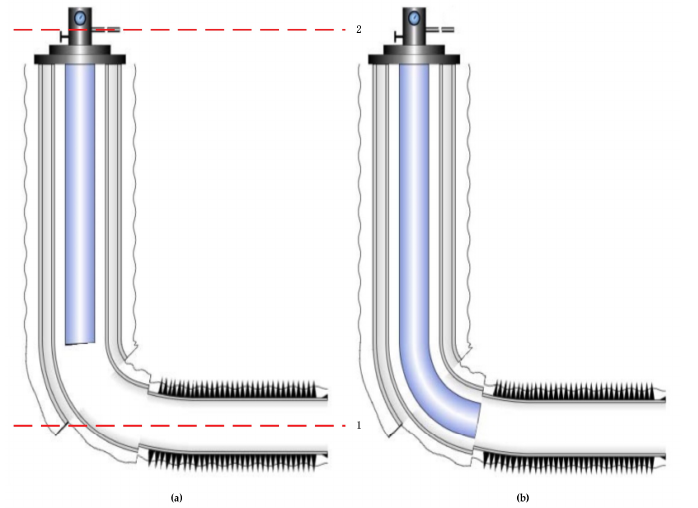
Figure 8. Well structure when the tubing reaches the upper part of the inclined section: ( a ) upper b ) heel of horizontal of inclined section; ( b ) heel of horizontal section. inclined section; (